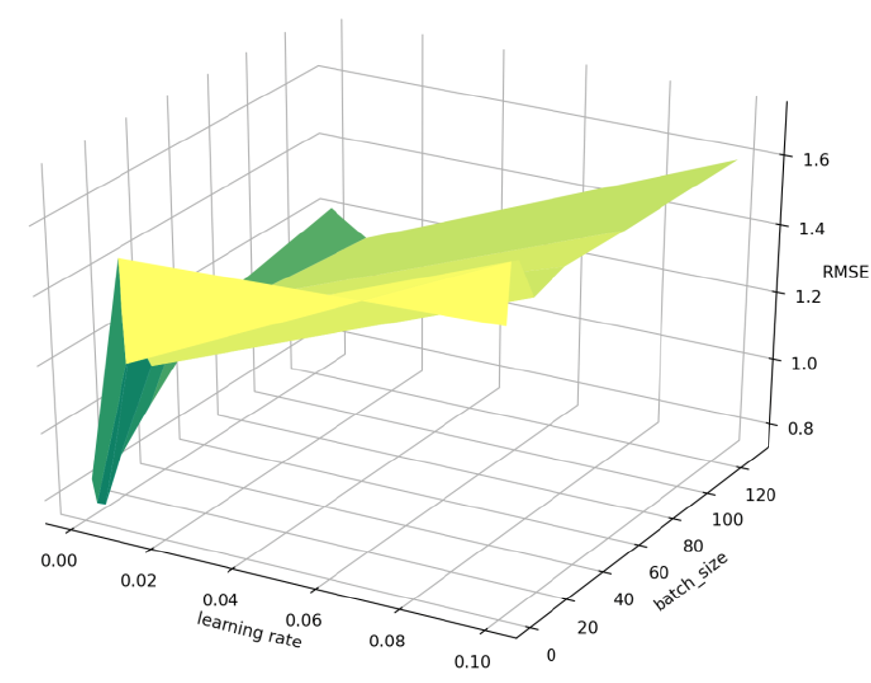
Figure 10. Impact of the parameter batch_size and learning